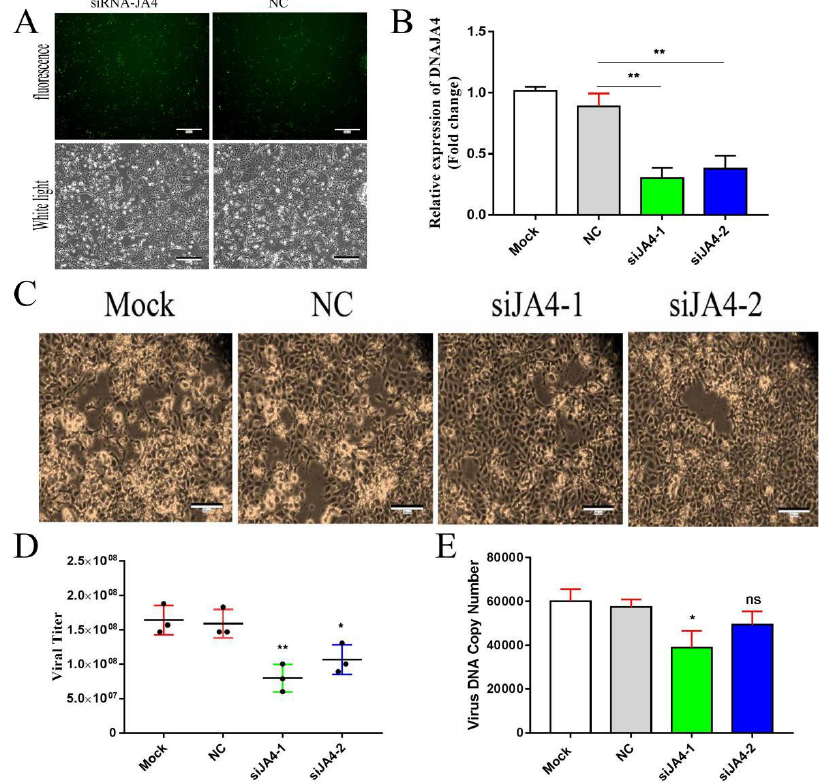
Figure 5. Knockdown of DNAJA4 by siRNA attenuates CGSIV replication and CGSIV DNA replication: ( A ) transfection efficiency of fluorescent siRNA; ( B ) qPCR detection of siRNA interference effect; ( C ) results of siRNA interference with CPE; ( D ) effect of siRNA interference on the titer of CGSIV virus; and ( E ) effect of siRNA interference on genome replication of CGSIV virus. The results were expressed as mean ± SD, ( n = 3; * p < 0.05; ** p <